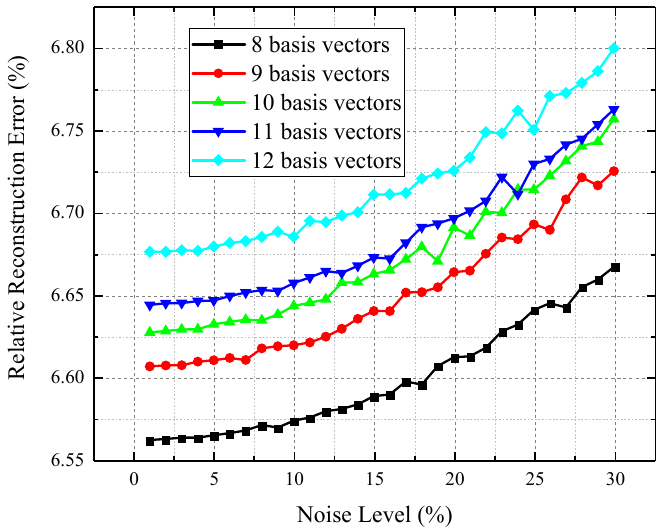
Figure 10. Joint effect of the number of basis vectors and the noise level (%) on the reconstruction error (pressure field).